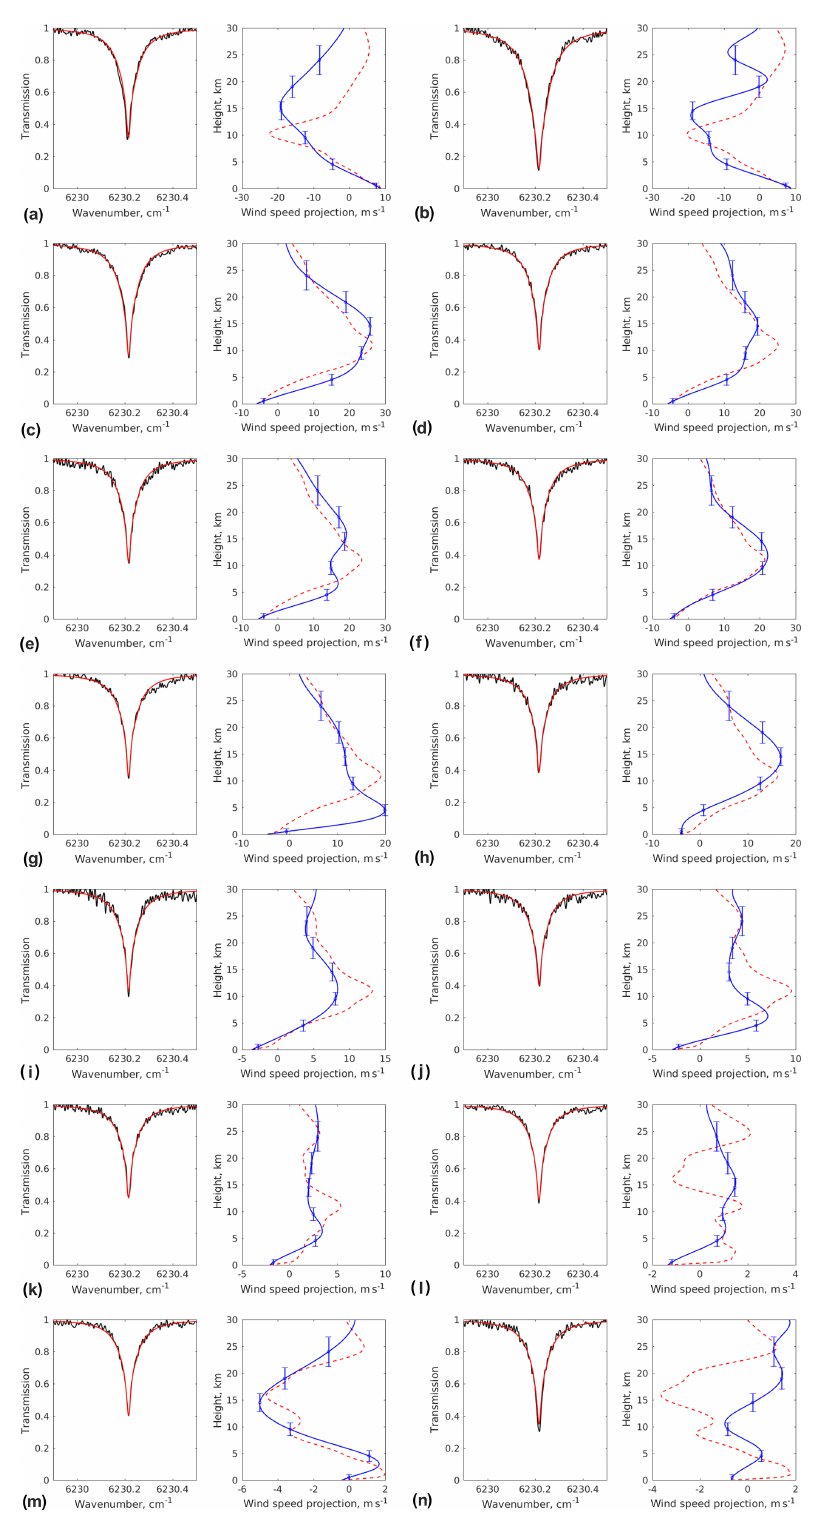
Figure 4. Comparison of retrieved wind projection on the line of sight (right panels, blue curve) with reanalysis data (red dashed curve). Vertical error bars correspond to FWHM of a retrieval averaging kernel presented in Fig. 3. Left panels show atmospheric transmission spectrum measured by means of heterodyne technique (black curve) and the corresponding best-fit model spectrum (red curve). Date and local time of each observation are presented in Table